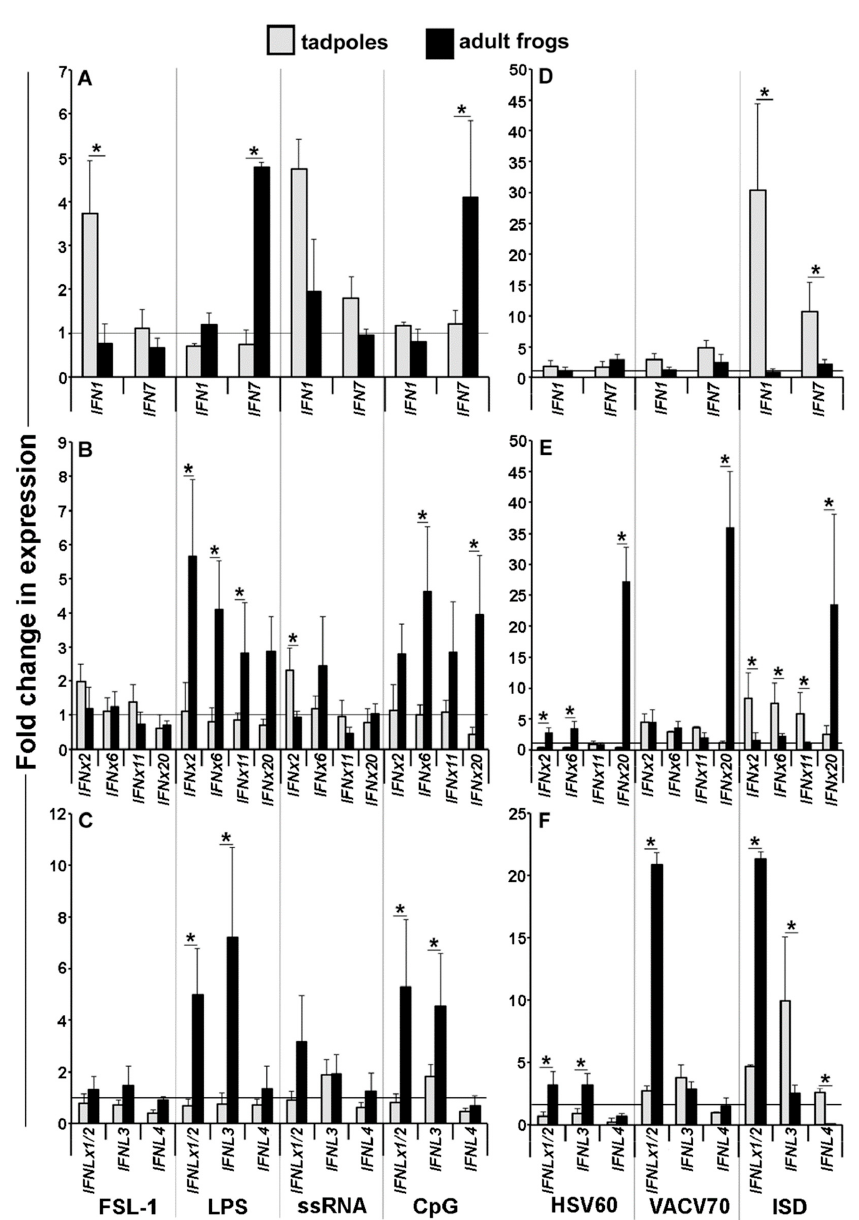
Figure 2. Tadpoles and adult frog skin cells mount distinct interferon (IFN) responses to PAMP stimulations. Tadpoles (NF 54, N = 5) and adult frog (1 year old, N = 5) skin cells were isolated and stimulated with a panel of pathogen-associated molecular patterns (PAMPs) for 6 h, and the IFN gene expression was examined. ( A ) IFN1 and IFN7 ; ( B ) IFNx2 , IFNx6 , IFNx11 , IFNx20 ( C ) IFNLx1/2 , IFNL3 , and IFNL4 gene expression, following stimulation with TLR and RIGI-specific PAMPs. ( D ) IFN1 and IFN7 ; ( E ) IFNx2 , IFNx6 , IFNx11 , and IFNx20 ; ( F ) IFNLx1/2 , IFNL3 , and IFNL4 gene expression, following stimulation with CDS agonists. All of the gene expressions were compared to the GAPDH control, normalized against the mock-infected expression of the respective genes within given tissues. All of the results are presented as means + SEM. Significant differences between the respective experimental groups are denoted by overhead lines and asterisks (*). p < 0.05.